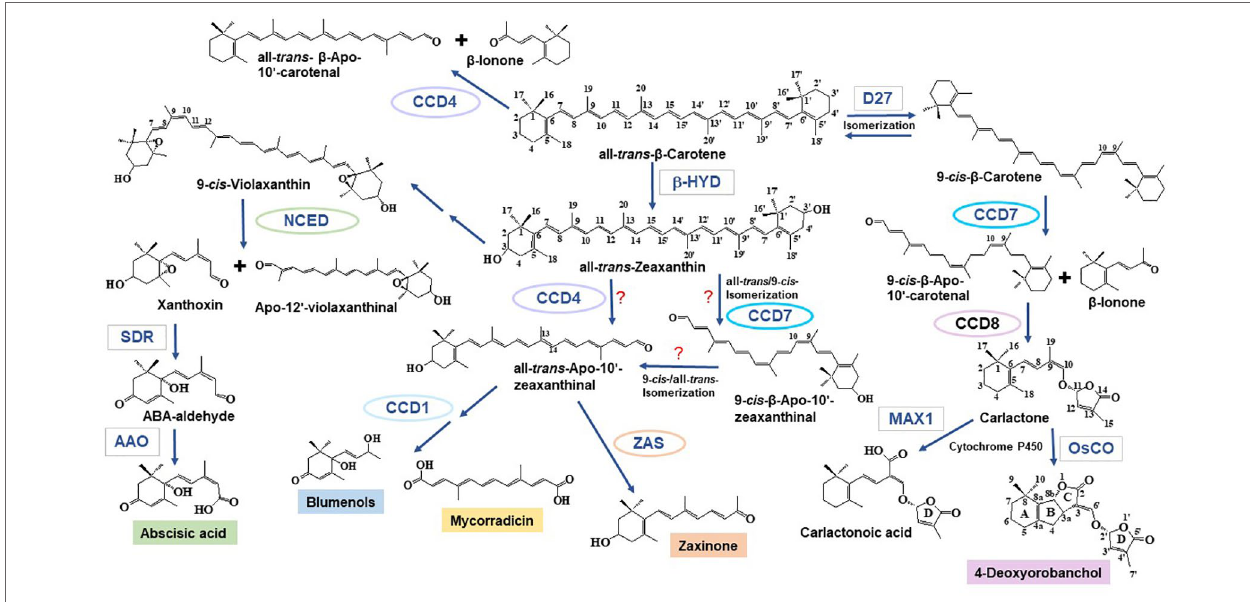
FIGURE 1 | Formation of apocarotenoids involved in mycorrhization. Nine- cis -epoxycarotenoid dioxygenase (NCED) enzymes catalyze the cleavage of 9- cis - violaxanthin—formed from all- trans -zeaxanthin through epoxidation and isomerization reactions—and 9’- cis -neoxanthin (not shown) into the ABA precursor xanthoxin and apo-12’-violaxanthinal (or apo-12-neoxanthinal, not shown) (Nambara and Marion-Poll, 2005). Xanthoxin is then further converted to ABA by SDR and AAO. Carotenoid cleavage dioxygenase (CCD) enzymes catalyze a set of different carotenoid and apocarotenoid cleavage reactions. The C 27 apocarotenoids β -apo-10’-carotenal and/or β -apo-10’-zeaxanthinal may be formed by CCD4 enzymes that cleave all- trans -bicyclic carotenoids (Bruno et al., 2015; Bruno et al., 2016). CCD7 has been also implicated in the formation of all- trans - β -apo-10’-carotenoids, which include the zaxinone precursor all- trans - β -apo-10’-zeaxanthinal (see below); however, in this case, a cis to trans isomerization must be postulated, as the apo-10’-carotenoids produced by CCD7 enzymes are 9- cis -configured (Alder et al., 2012; Bruno et al., 2014). Several enzymatic studies show that CCD1 enzymes can produce C 14 directly from carotenoids or—in a secondary cleavage reaction—from all- trans - β -apo-10’-carotenoids. In the case of mycorrhizal tissues, it is assumed that they use β -apo-10’-carotenoids as substrate to form precursors of mycorradicin and blumenols (structure shown as blumenol C), which accumulate in AM-colonized root and act as symbiosis signal in plant leaves, respectively (Floss et al., 2008b; Walter et al., 2010; Hou et al., 2016; Wang et al., 2018). Following β -carotene isomerization catalyzed by D27, the SL biosynthetic enzyme, CCD7, cleaves 9- cis - β -carotene into 9- cis - β -apo-10’-carotenal and β -ionone. This step is followed by the CCD8-catalyzed conversion of 9- cis - β -apo- 10’-carotenal into carlactone. Carlactone, a central intermediate in SL biosynthesis, is further modified by cytochrome P450 enzymes of the 711 clade (i.e., the Arabidopsis MAX1 (Abe et al., 2014), the rice carlactone oxidase (Zhang et al., 2014), which yield canonical, e.g., 4-deoxyorobanchol, and non-canonical, e.g., carlactonoic acid, SLs. Carlactonoic acid is further modified into different products (Alder et al., 2012; Bruno et al., 2014; Al-Babili and Bouwmeester, 2015; Bruno et al., 2017; Abuauf et al., 2018; Jia et al., 2018). ZAS, a recently identified CCD, cleaves apo-10’-zeaxanthinal, yielding the novel signaling molecule, zaxinone (Wang et al., 2019). β -Apo-10’-zeaxanthinal could be formed from zeaxanthin or lutein (not shown) by CCD4 enzymes. Enzymes are surrounded either by ellipses (CCDs) or rectangles (other enzymes). SDR, short chain dehydrogenase reductase; AAO, Abscisic aldehyde oxidase; β -HYD, β -hydroxylase; D27, DWARF27; MAX1, more axillary growth1; OsCO, rice carlactone oxidase, a MAX1